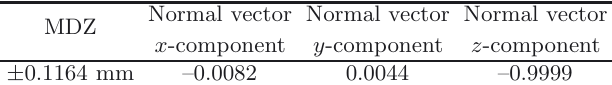
Table 1. MDZ and normal vector of the optimum substitute plane for 148 722 data points.